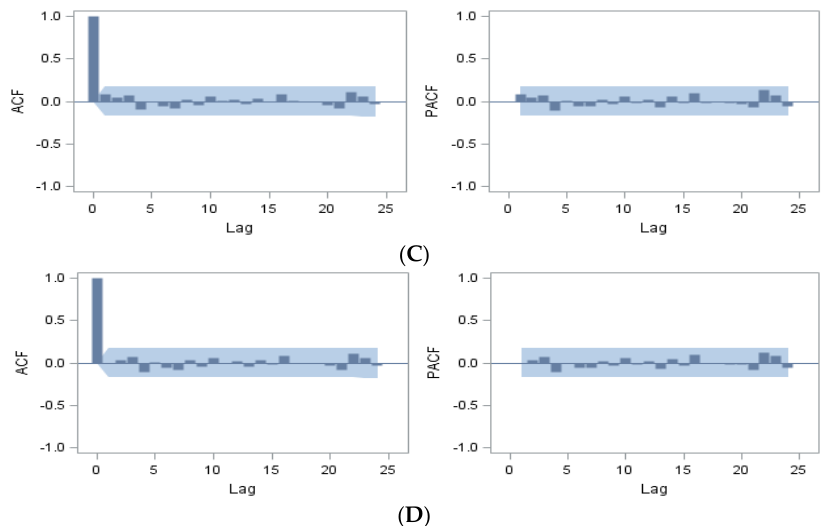
Figure 3. The acf and pacf pattern (3( A ); 3( B ); 3( C ); and 3( D )) for residuals of ARIMA(1,0,0) 12 , ARIMA(0,0,1) 12 , ARIMA(1,0,1) 12 , and ARIMA(1,0,0) × (1,0,1) 12 , respectively. Gray area represents the two standard error limits.